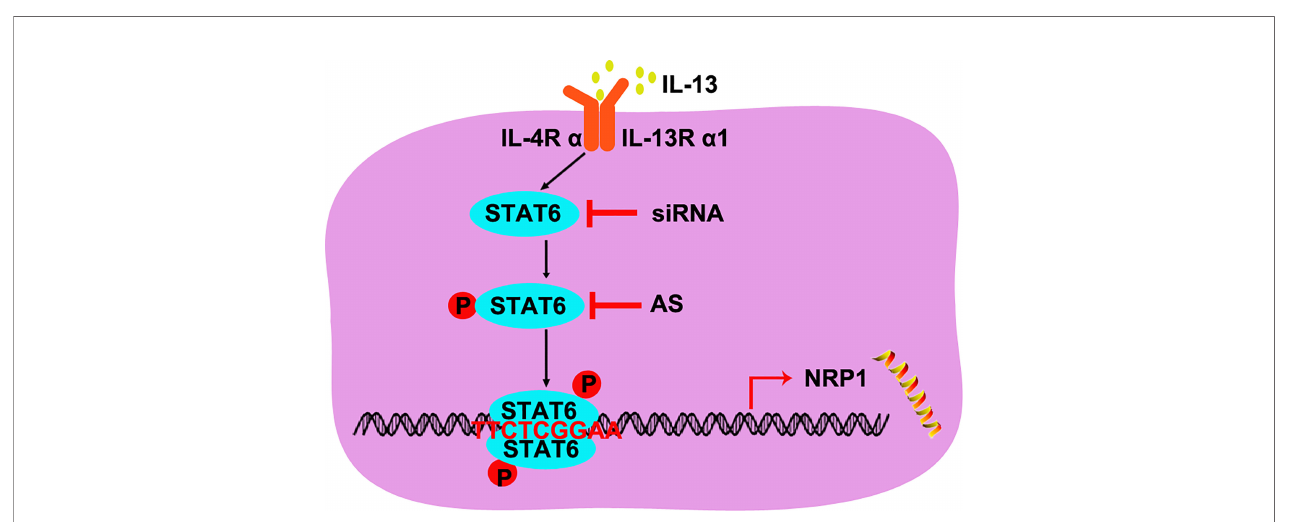
FIGURE 7 | A schematic underlying the mechanism of STAT6-promoted NRP1 expression in